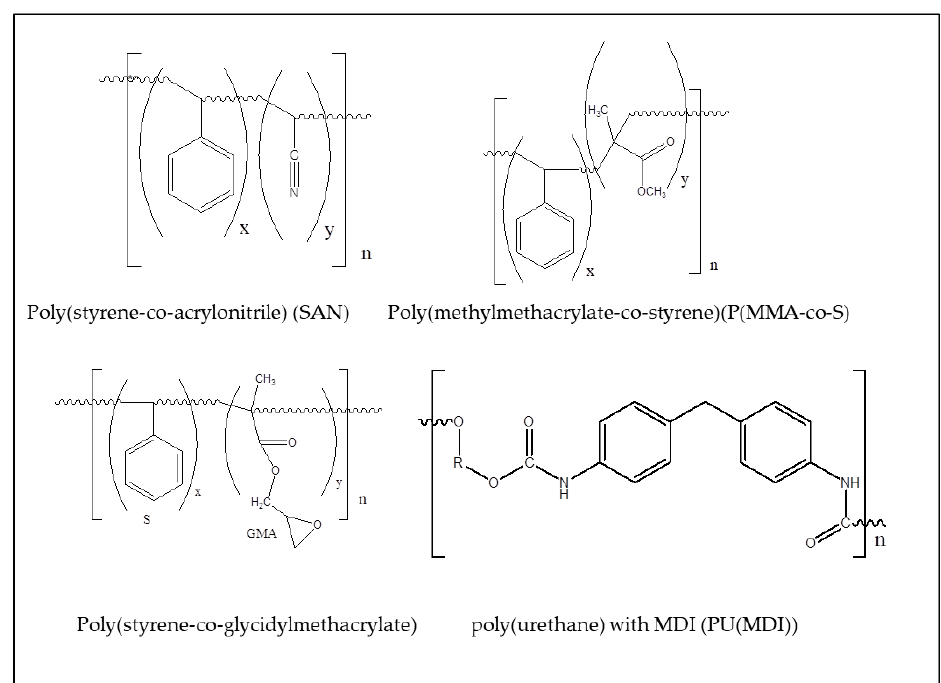
Scheme 3. Chemical structure of the comonomer units of copolymers used with DLIP.